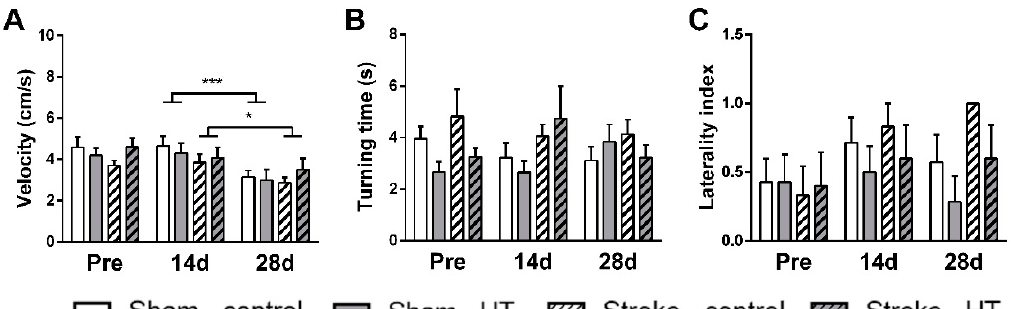
Figure 6. Motor coordination assessed pre-stroke and 14 days and 28 days post-stroke by the pole test. ( A ) Downwards walking velocity. ( B ) Time to turn around on the pole (turning time) and ( C ) tendency to turn right vs left (laterally index). ( A ) At 28 days post-surgery, sham mice ( p < 0.001) and stroke mice ( p < 0.049) walked down the pole with a lower velocity compared to 14 days post-surgery. Values represent mean ± SEM. Values represent mean ± SEM. * p < 0.05, *** p < 0.001.